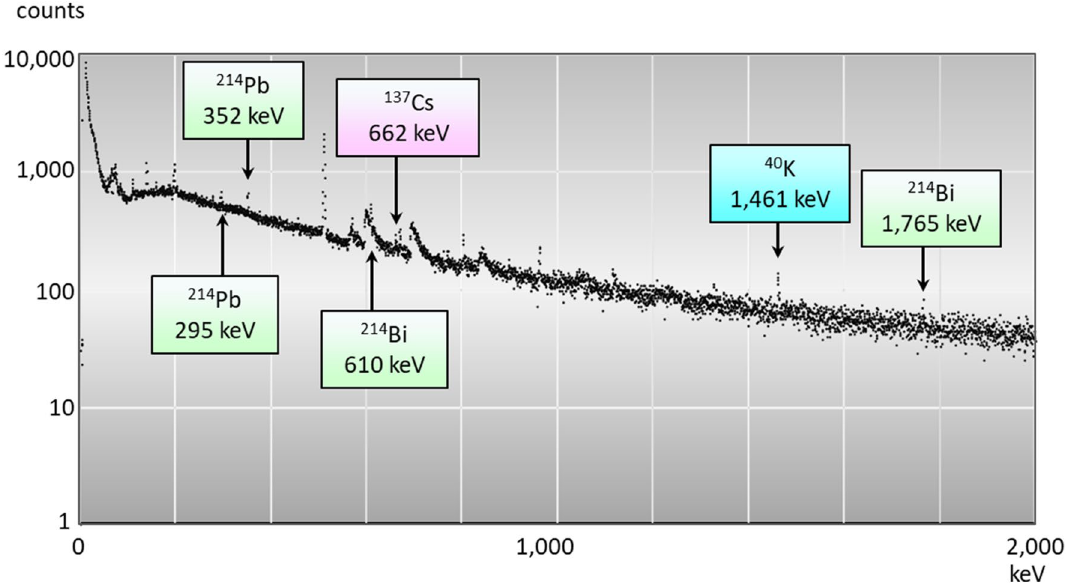
Figure 2. Typical gamma-ray spectrum including the peak of 137 Cs in deciduous teeth. The ordinate shows counts measured for 3 million seconds (34.7 d).